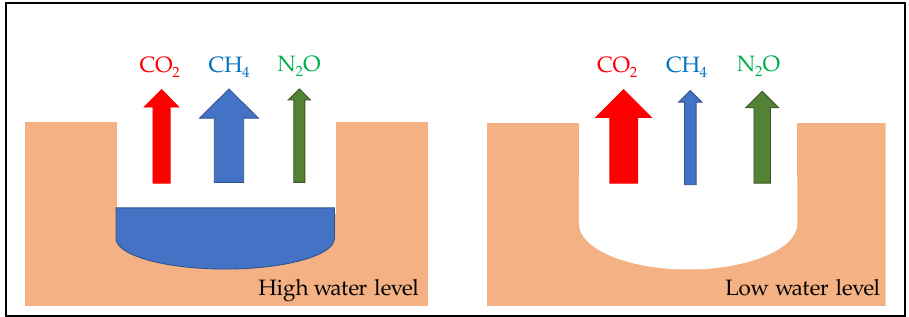
Figure 4. Changes in greenhouse gases emissions as a function of water level. The size of the arrow represents the relative magnitude of each flux.